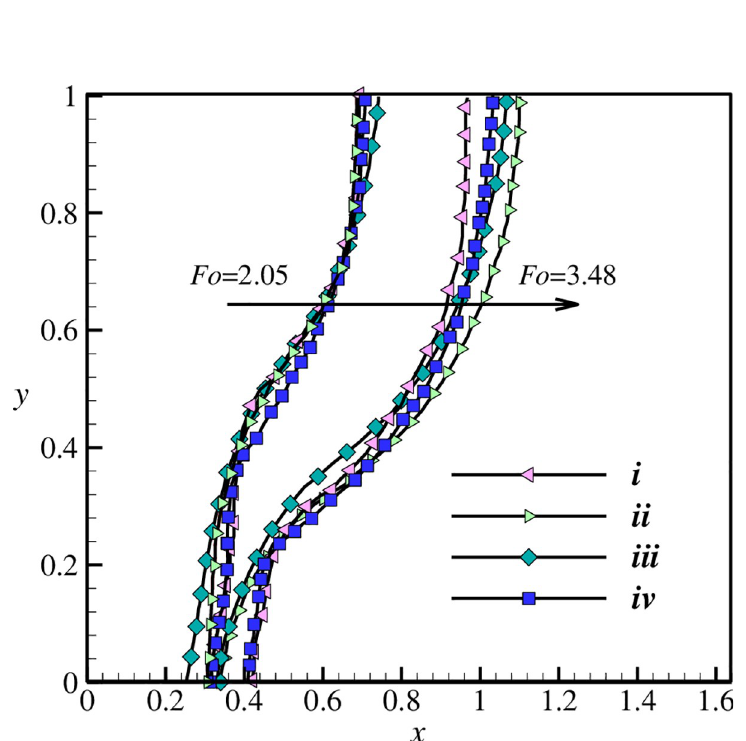
Fig 6. The melting interface simulated in the present study and the literature review of [57]; i: Kashani et al., ii: Gau and Viskanta (experiment); iii: Brent et al., and iv: present work.